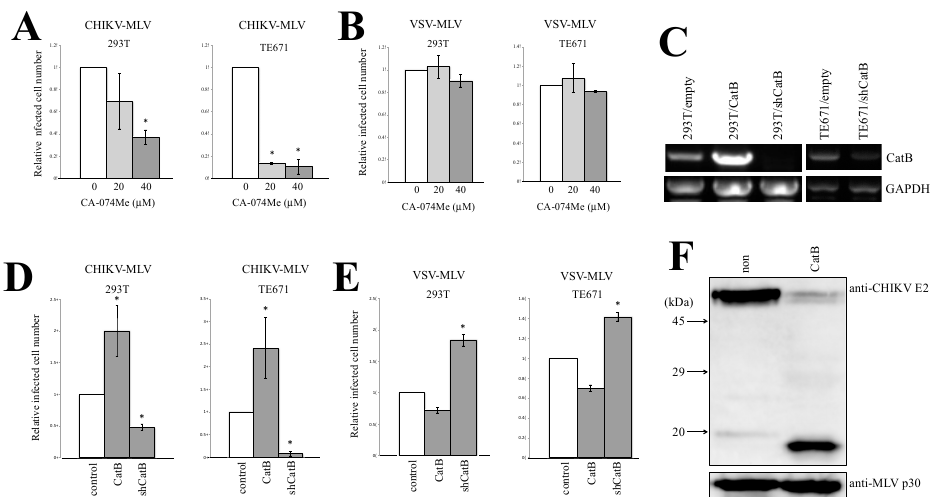
Figure 6. Cathepsin B is required for CHIKV-pseudotyped MLV vector infection in 293T and TE671